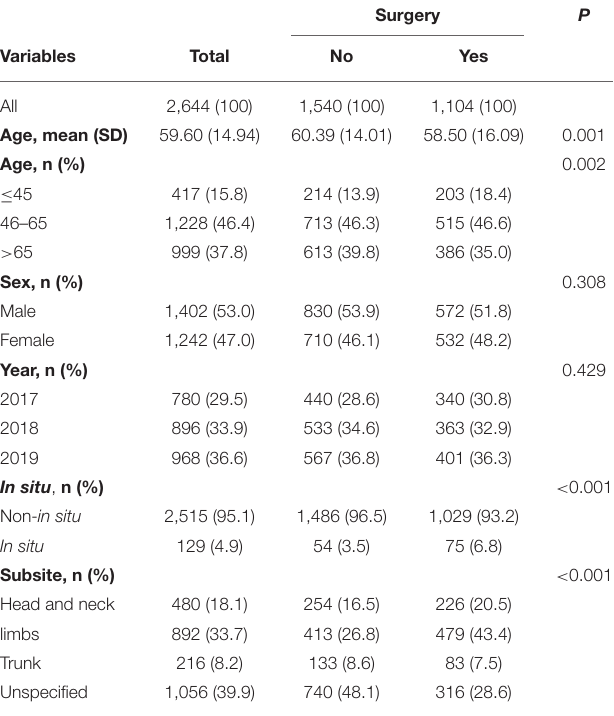
TABLE 1 | Baseline characteristics of Hunan melanoma inpatients from